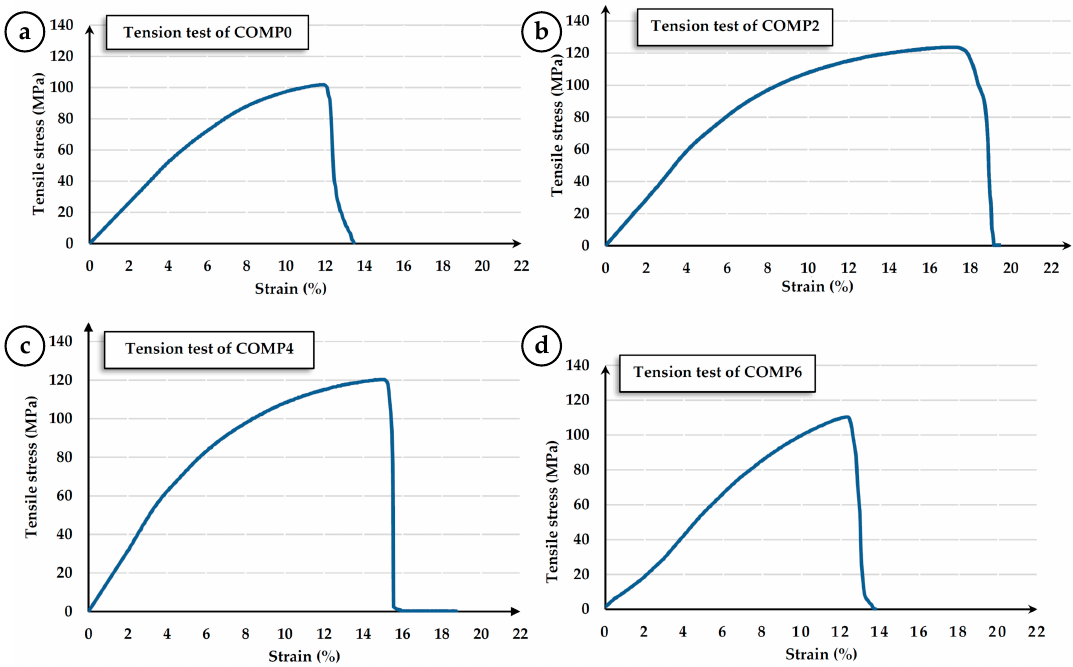
Figure 7. The stress–strain behavior of the fabricated composites taken at room temperature and strain rate of 0.5 mm/mine. ( a ) Tension test of COMP0; ( b ) Tension test of COMP2; ( c ) Tension test of COMP4; ( d ) Tension test of COMP6.